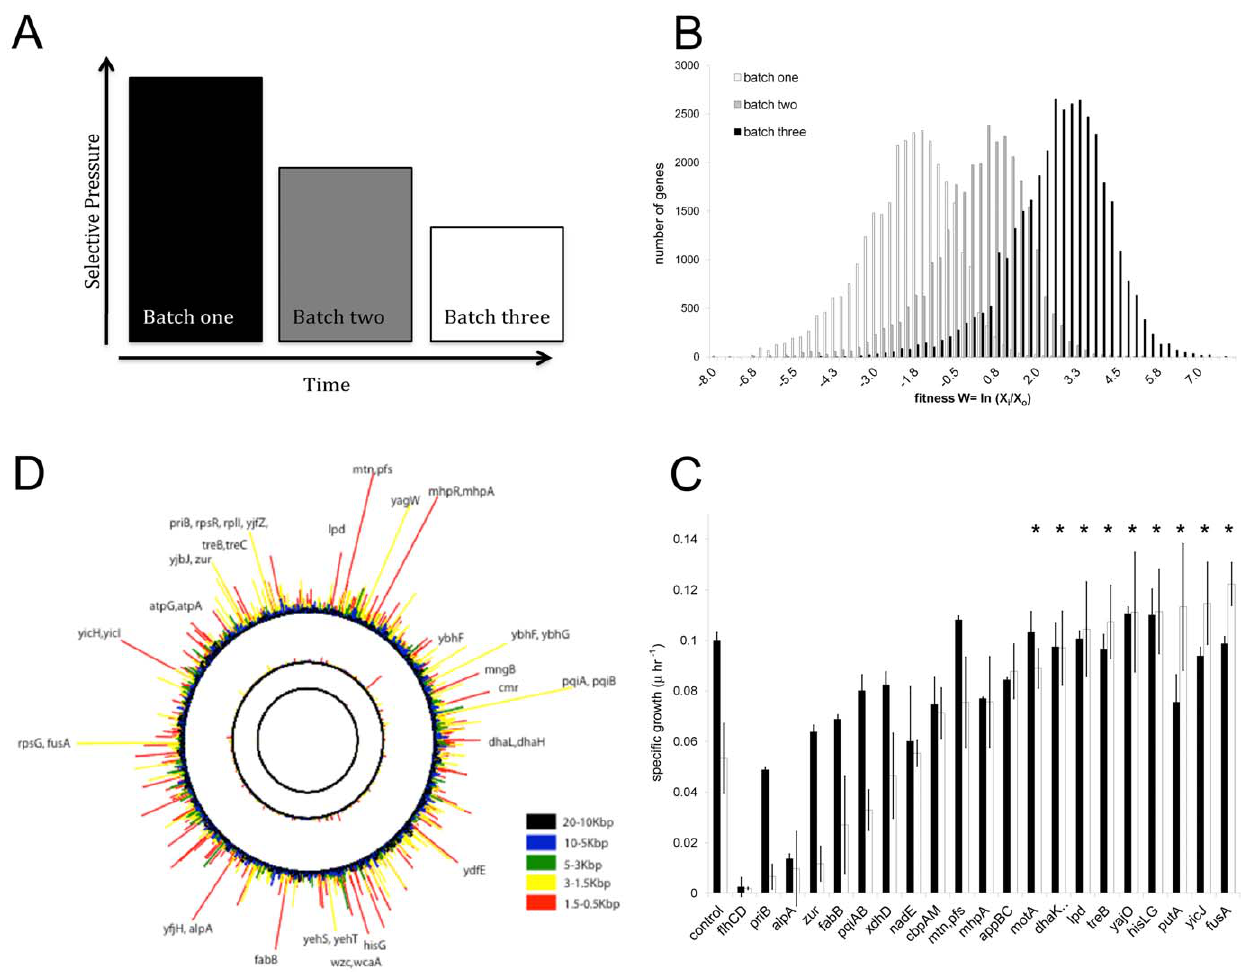
Figure 1. Selection Design. A) Strategy: unlike customary selections, our design decreases selective pressure (AMP concentration) through each successive batch. B) Histogram of each selected population displaying the increase in relative fitness over time through the three successive batches. C) Genome-wide plot of the multi-scale analysis of the fitness of each successive batch culture compared to the control culture at time 0. For each batch, the fitness for each 125-bp position is plotted around the genome for each scale referred to in the legend. A decrease in selective pressure (through each successive batch) moves outwards from the center circle. Circles i, ii, and iii correspond to the (6 m g/ml, 5 m g/ml, 4 m g/ml)/Control, (6 m g/ml, 5 m g/ml)/Control, and 6 m g/ml/Control, respectively. The percentage of the E. coli genome is plotted clockwise around the circles. Inserts with high fitness values are labeled. D) Growth of SCALEs selected clones. The specific growth of clones grown in 96 well plates and the OD 600 taken every half hour for eight hours is plotted. Black bars indicate the specific growth of clones in the absence of Bac8c. White bars indicate the specific growth of the clones in the presence of Bac8c at a concentration equal to the IC 50 of the control (3 m g/ml). The rpsLG-fusA , putA and yicJ clones all had an increased growth rate compared to the control strain in the presence of Bac8c at the IC 50 . *p-value , 0.01 is for the white bars (IC50), t-test